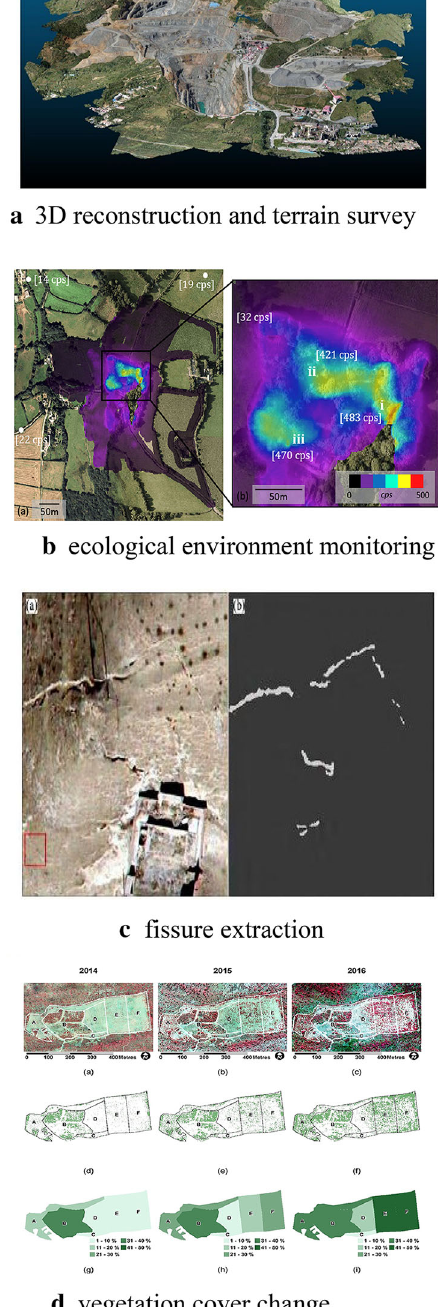
Fig. 4 Representative results from UAVs in MA: a 3D-view of the point cloud by digital camera (Chen et al. 2015); b radiological map with Kromek TM GR1 detector in legacy uranium mine (Martin et al. 2015); c Fissure extraction based on a knowledge model (Wang et al. 2015); d Woody cover change with Sony digital camera and MicaSense RedEdge multispectral sensor (Whiteside and Bartolo